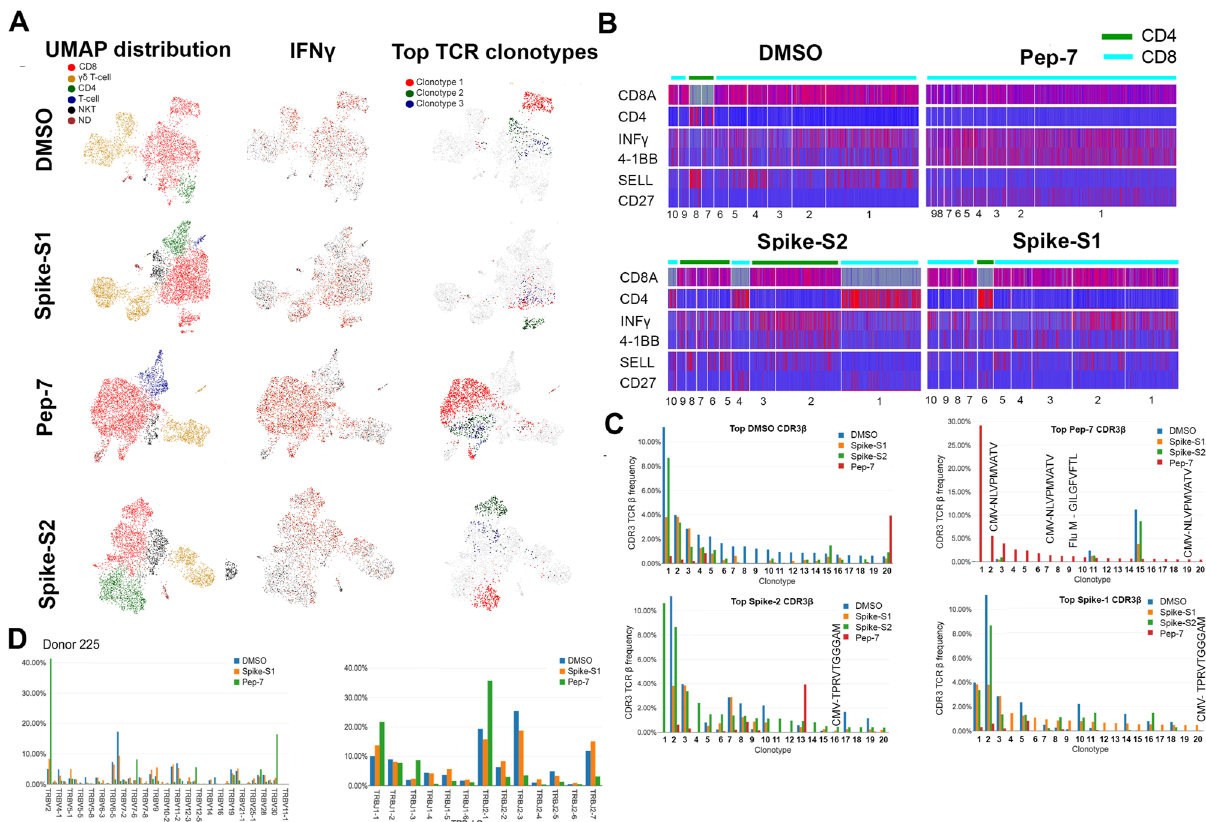
Figure 4. UMAP projection of different cell types identified in unexposed donor D225 after 14 days of in vitro stimulation assay with different antigens. ( A ) Clusters of different cell types and their relative proportions present in the assay mixture (left panel). Clusters expressing IFN-γ (middle panel) and the top-3 amplified clonotypes (right panel). ( B ) Heat map showing the expression of cell-type and cell-phenotype-specific markers in the top-10 amplified TCR-β clones. ( C ) Frequency of CDR3-β recognizing public and private antigens in the top 20 clonotypes. ( D ) Amplified V and J-genes in the top-20